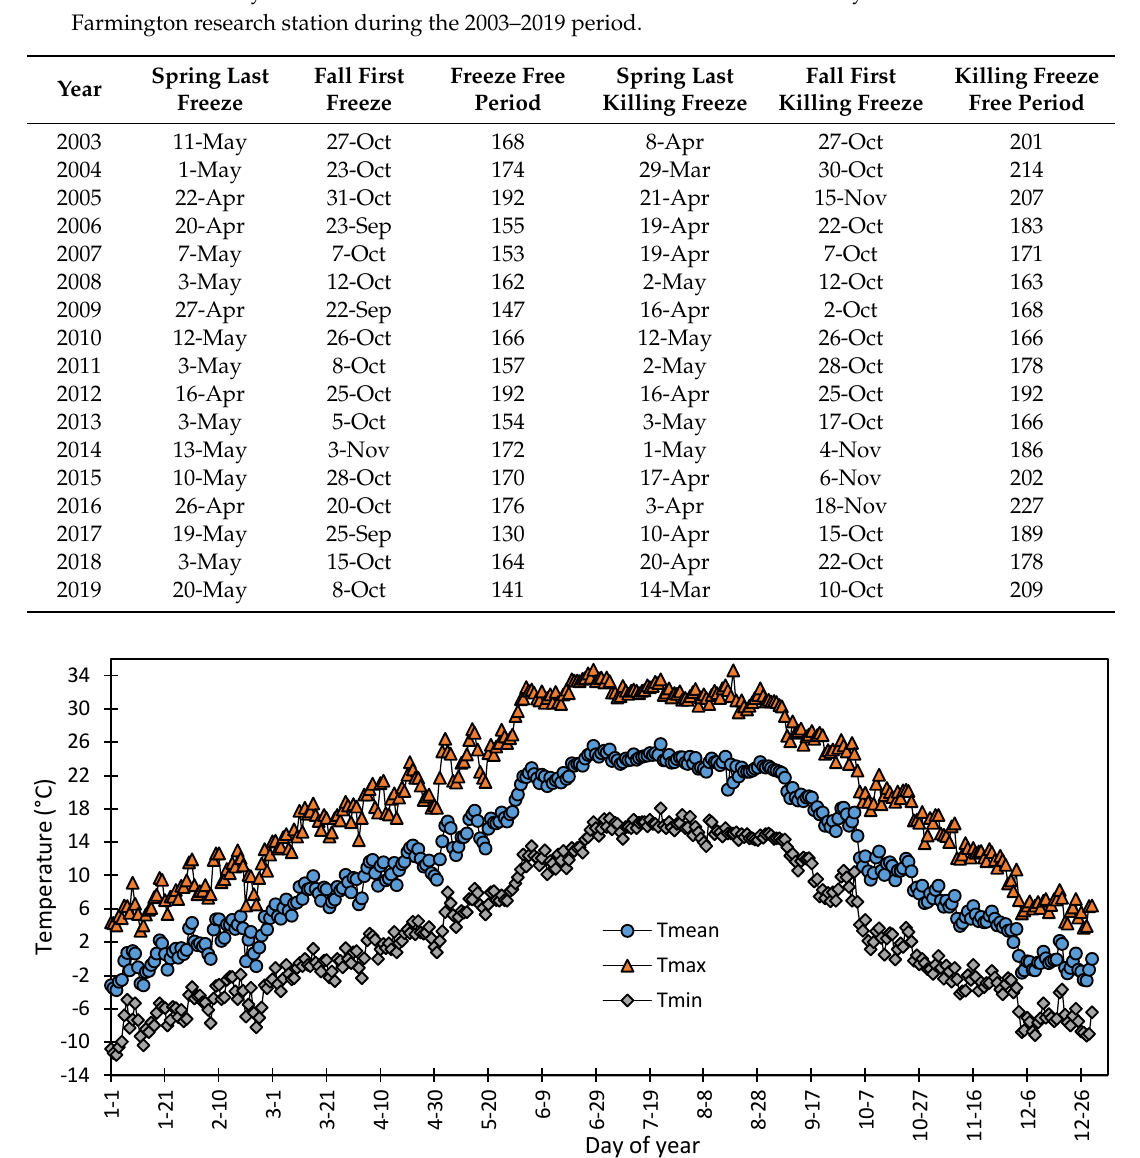
Figure 1. Trend in the daily average mean, maximum and minimum temperatures for 2003–2019 period at the Agricultural Science Center at Farmington, New Mexico.